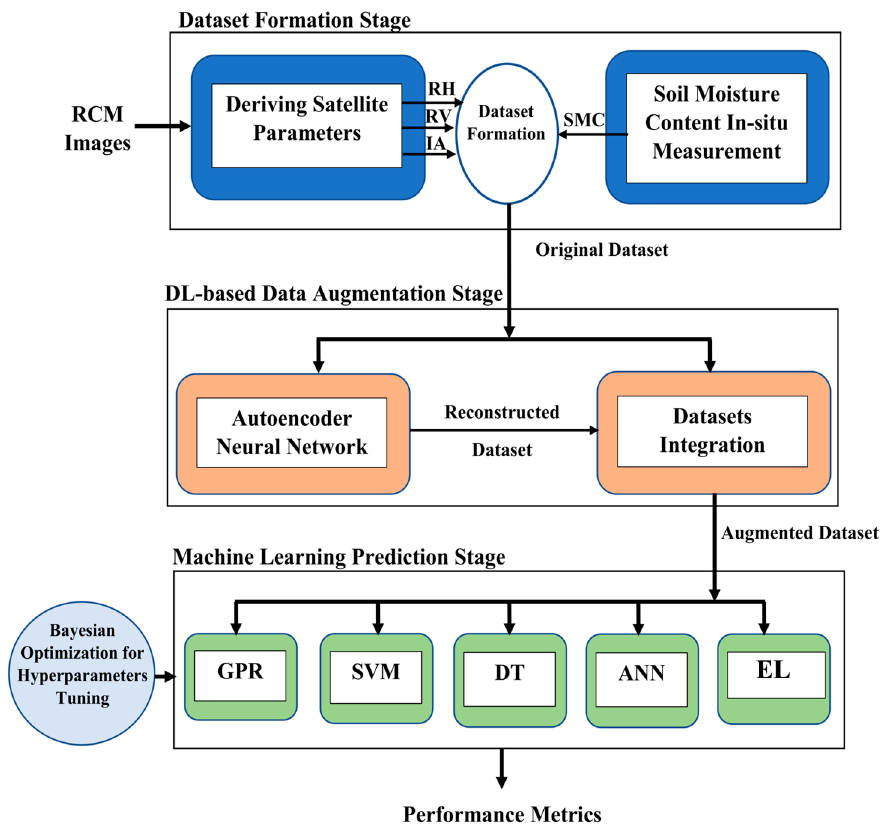
Figure 2. The proposed DL-based framework for soil moisture retrieval.